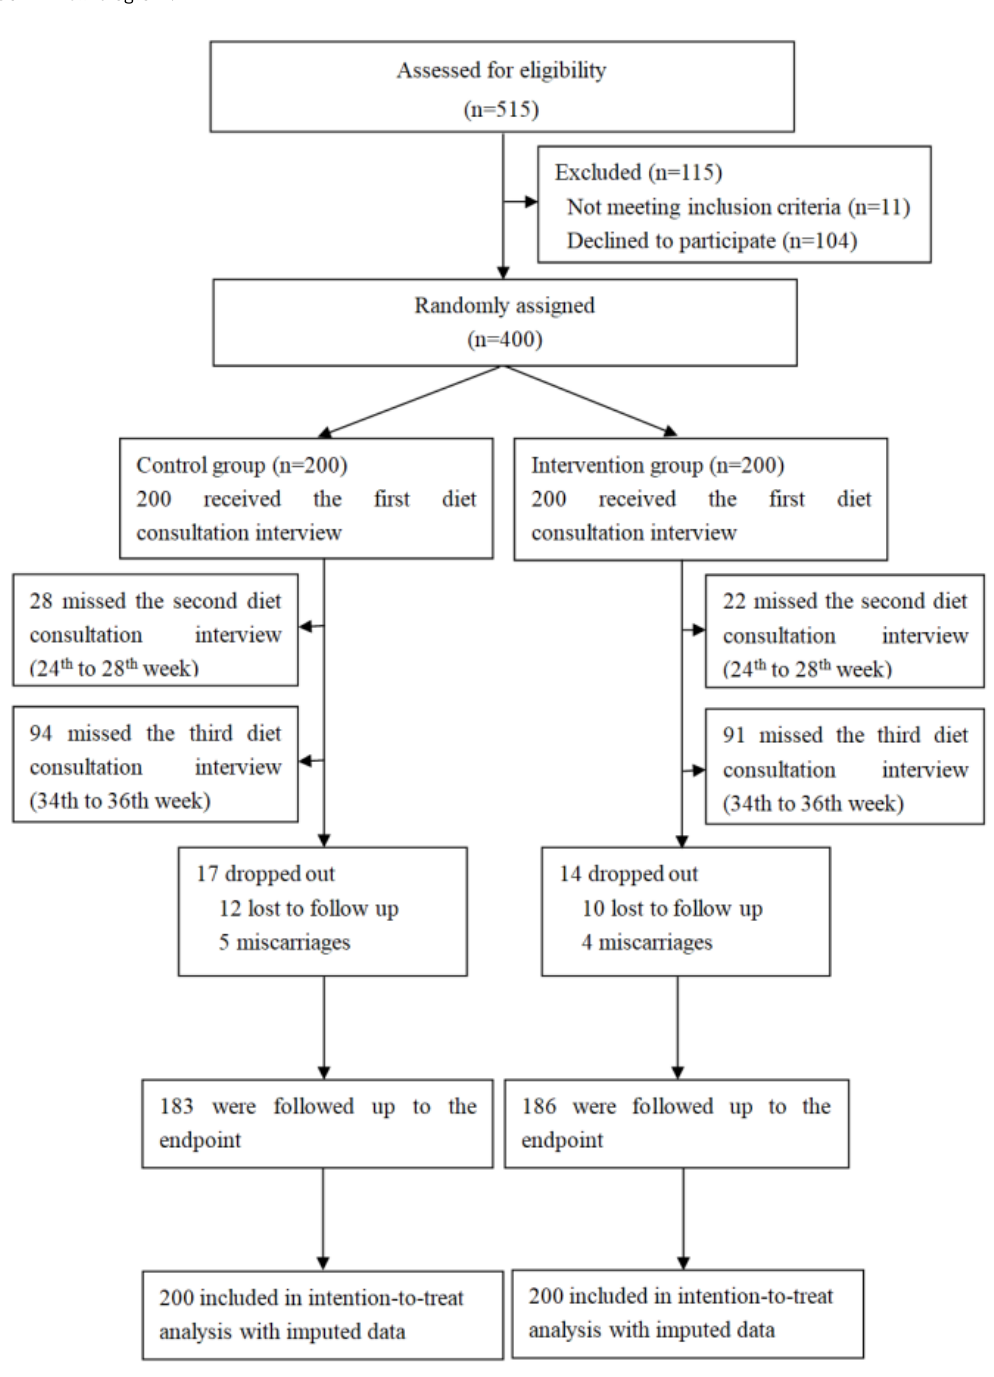
Figure 1. CONSORT flow